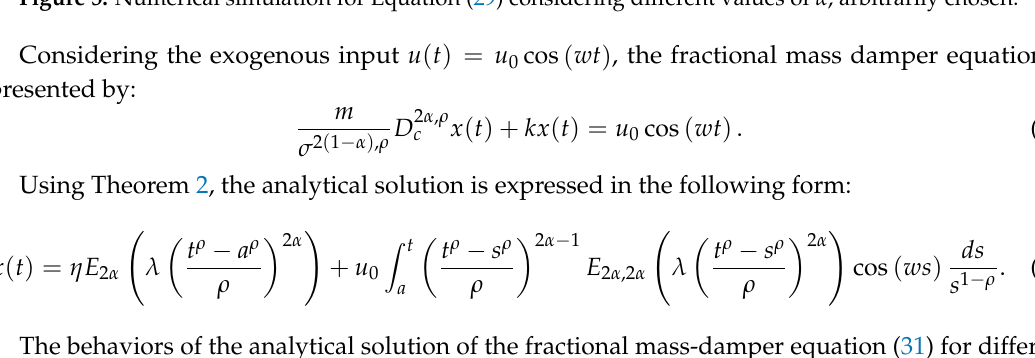
Figure 5. Numerical simulation for Equation (29) considering different values of α , arbitrarily chosen.